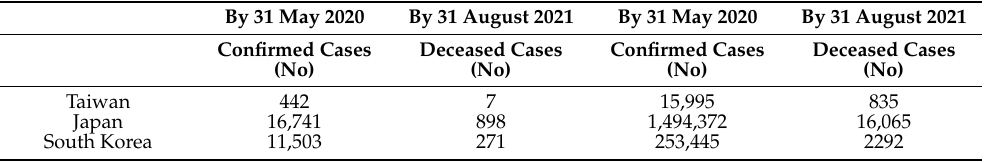
Table 1. Number of confirmed cases and deceased cased in comparison to neighboring countries of Taiwan such as Japan and